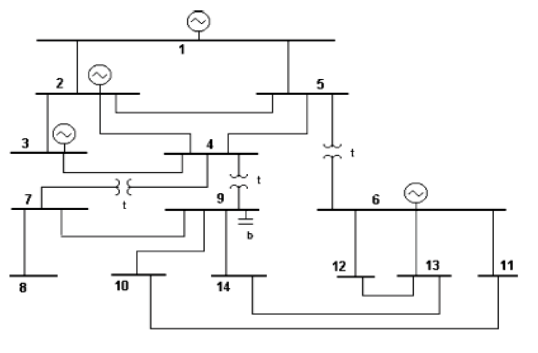
Fig.6. IEEE 14 Bus network